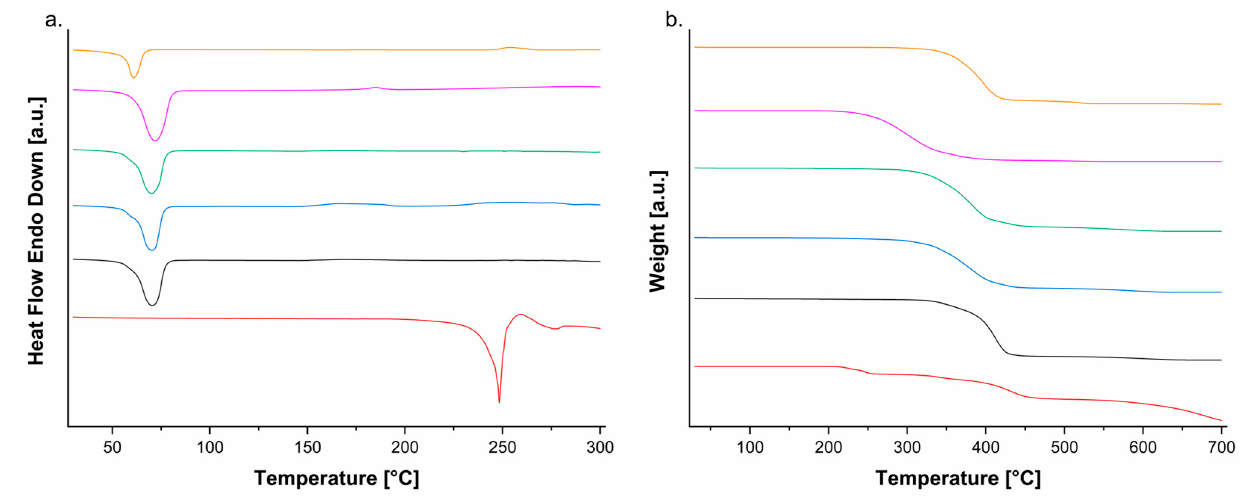
Figure 2. ( a ) DSC and ( b ) TGA curves superposition of Fen (red), formulation 1 (black), formulation 2 (blue), formulation 3 (green), PEO extruded (pink) and PCL extruded (orange) at heating rate of 10 °C min − 1 .